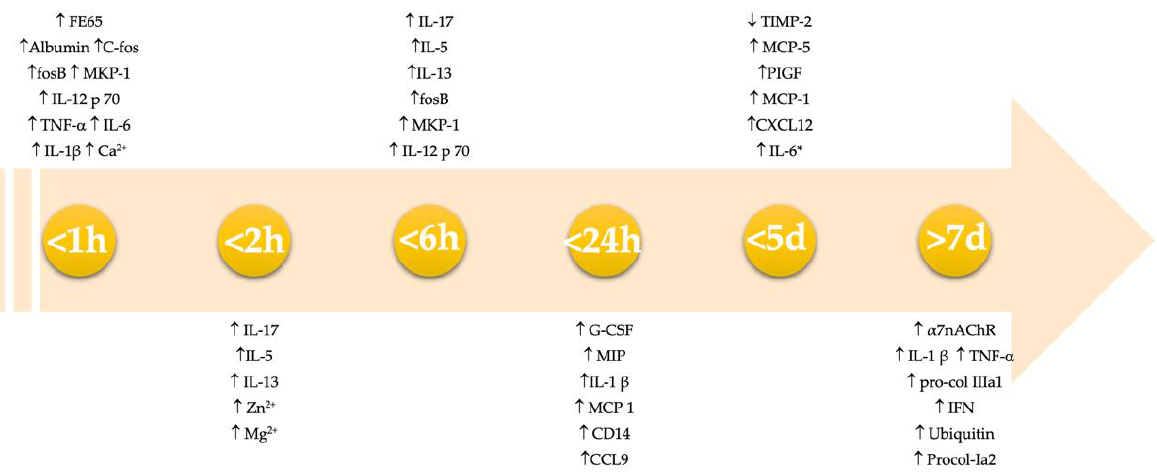
Figure 3. The differential expression of different biomarkers and electrolytes variations in skin as time (days) after wounding progress. H means “hours”; d means “day(s)”. We included all the biomarkers that showed a variation (increasing or decreasing) before 21 days. Regarding the biomarkers that showed an expression during an interval, only the upper limit has been considered. *IL 6 has been considered in different studies; it shows a different expression only in two studies. Table 5. This table shows the progressive variations of electrolytes and proteins in biological fluid after death. * Mb levels were influenced by putrefactive changes. TNF- α, tumor necrosis factor α; IL, interleukin; Mb, myoglobin; HMGB, high-mobility group box; EPO, erythropoietin; K+, potassium; Na+, sodium; Ca2+, calcium.